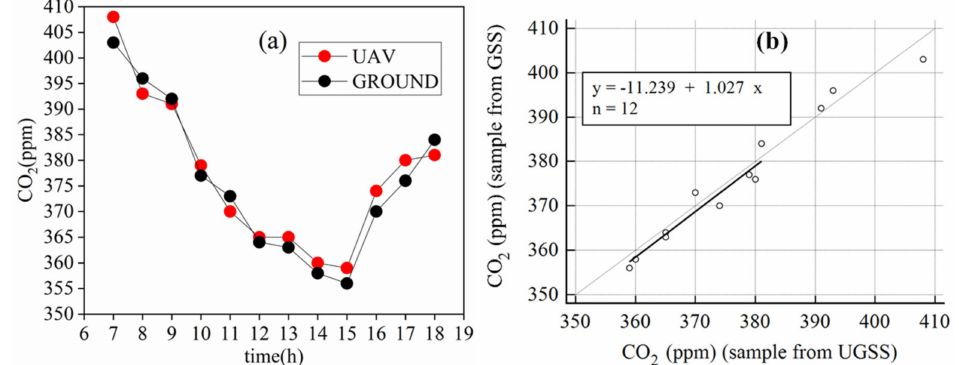
Figure 8. In graph ( a ): the PM2.5 / 10 concentrations collected by the UGSS and concentrations recorded by PM sensor at ground gas sampling station (GSS). In graph ( b ): Deming regression analysis of the CO 2 concentration sample from UGSS vs.